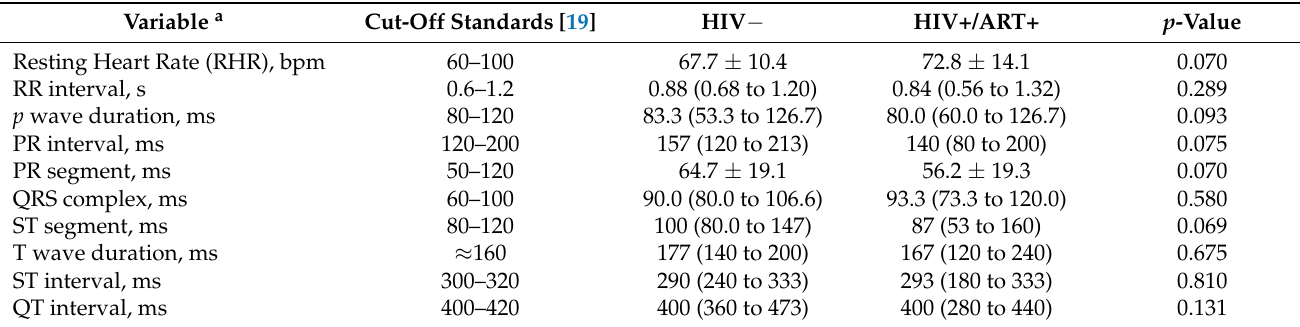
Table 3. Comparison of ECG variables between HIV+/ART+ and HIV −